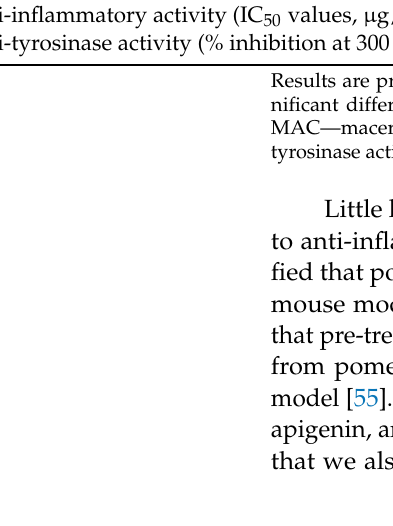
Table 5. Anti-inflammatory and anti-tyrosinase properties of P. granatum leaf hydroethanolic extracts. MAE Positive Control Anti-inflammatory activity (IC 50 values, µ